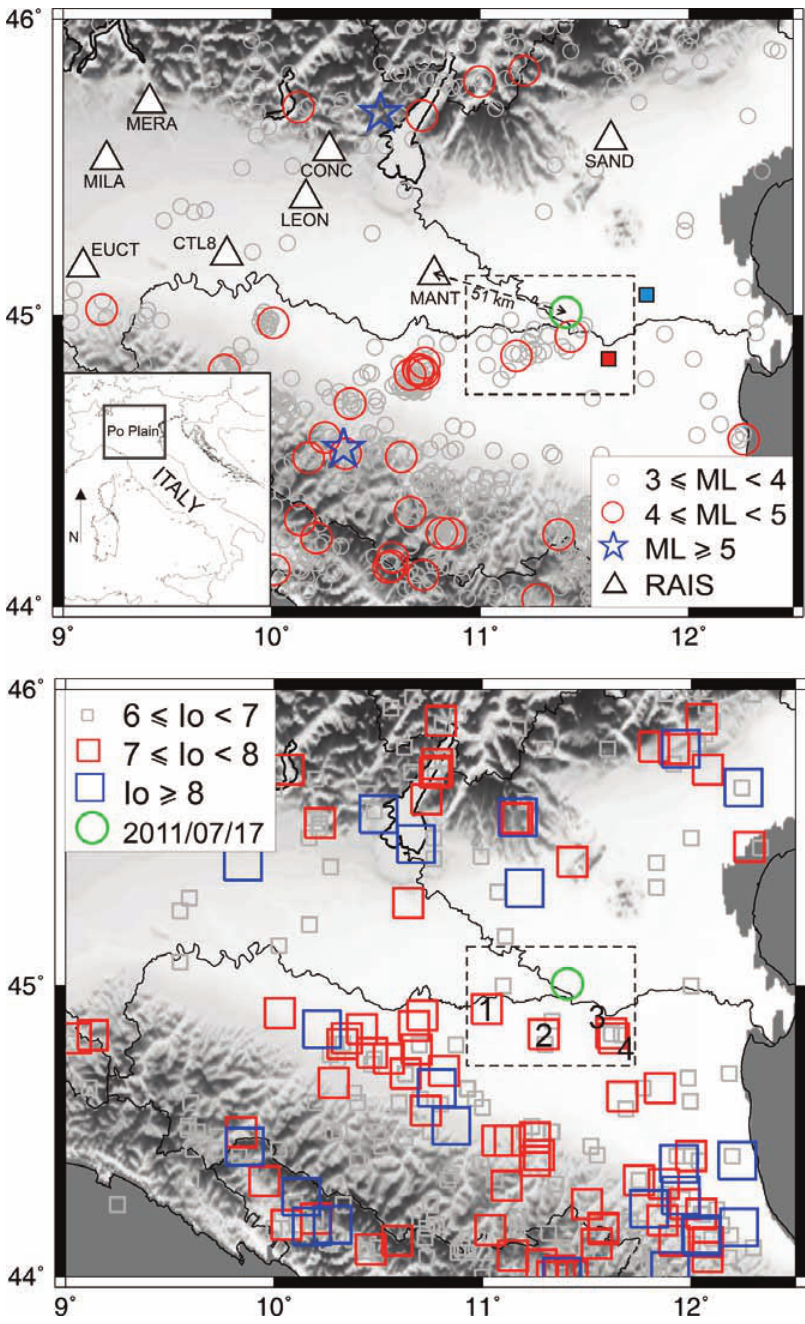
Figure 1. Seismicity of the Po Plain and surrounding areas considered. Top: Instrumental seismicity for the last 30 years (http://csi.rm.ingv.it/; http://iside.rm.ingv.it/iside). White triangles, RAIS stations (http://rais.mi.ingv.it). Red and blue squares, Ferrara and Rovigo, respectively. Inset: location of the study area in Italy. Bottom: Historical seismicity. Green circle, epicenter of the July 17, 2011, M